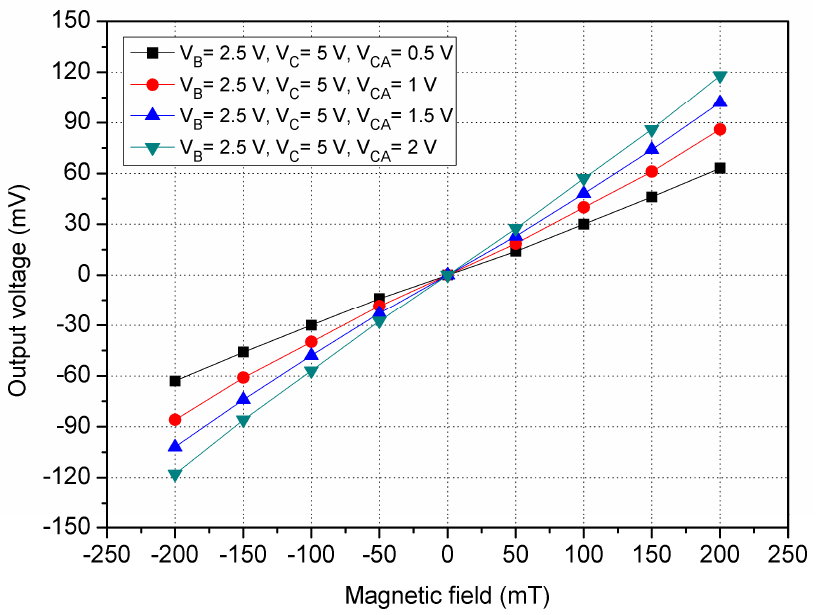
Figure 3. Simulated output voltage (Vo) in the x-direction MF. The x/y-MSE was applied by the y-direction MF, and the Vo of the x/y-MSE was the voltage difference of the additional collector AC 2 /AC 4 . Figure 4 shows the x/y-MSE Vo in the y-direction MF, where V B is the bias of the bases; V C is the bias of the collector and V CA is bias of the additional collectors. The results presented that the MS Vo increased from − 116 mV at − 200 mT to 116 mV at 200 mT when V B = 2.5 V, V C = 5 V and V CA = 2 V. The slope of the curve (at V B = 2.5 V, V C = 5 V and V CA =2 V) was 580 mV/T, so the evaluated sensitivity for the x/y-MSE was 580 mV/T at V B = 2.5 V, V C = 5 V and V CA = 2 V in the y-direction MF. The evaluated results of the x/y-MSE in the y-direction MF was the same with that in the x-direction MF because the x/y-MSE structure was a symmetric.